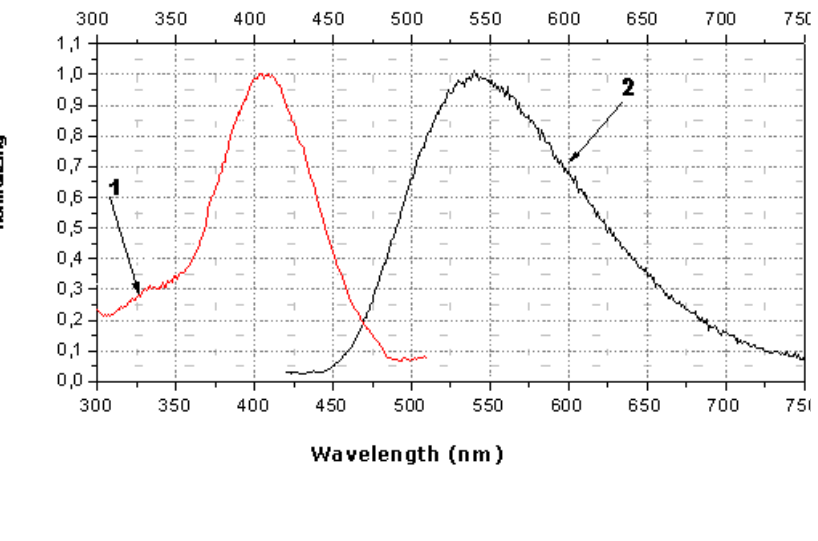
Figure 11. Spectra of absorption (curve 1, red) in comparison to fluorescence (curve 2, black) of mixed monolayer (OMS-5:C18 = 1:2) transferred from 1 mM solution of 1,3-diaminopropane